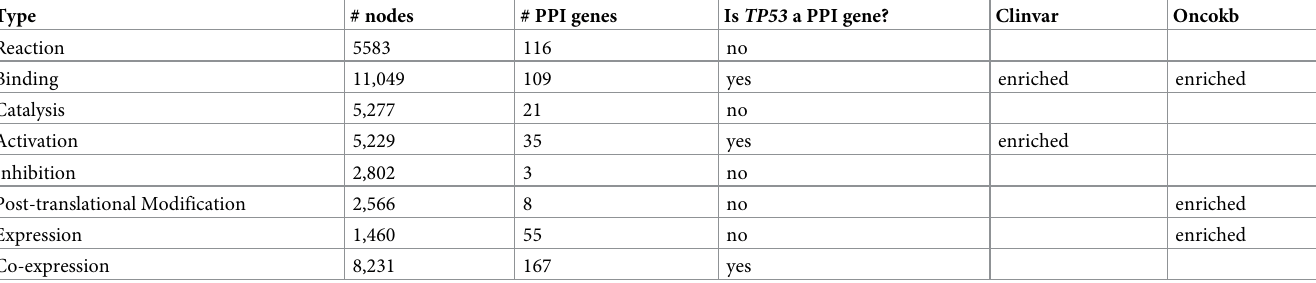
Table 2. Comparison of our method applied to networks built with different interaction